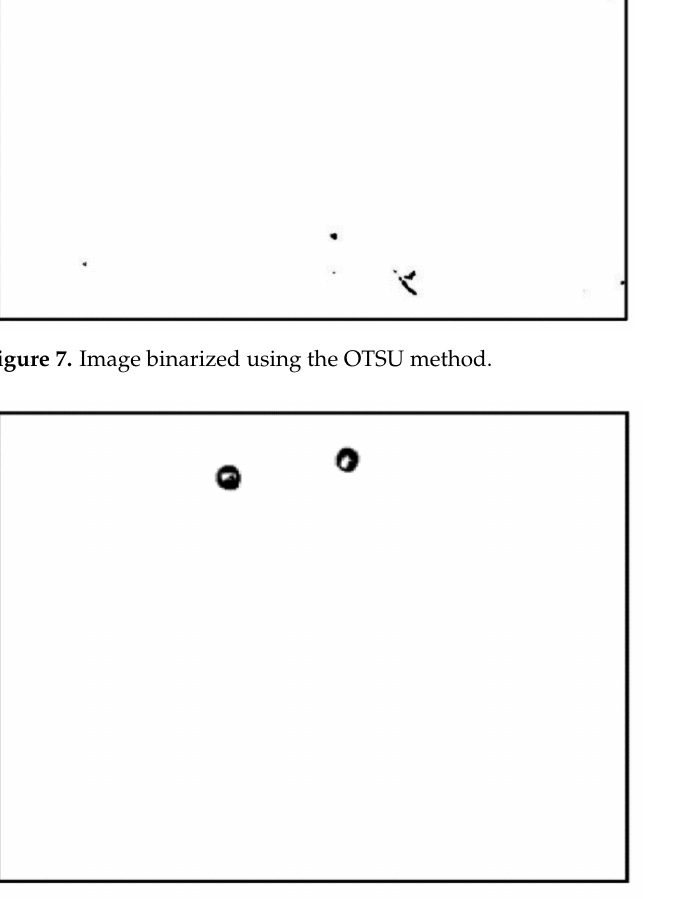
Figure 8. Complete cell outline after the image was denoised using the morphological method.